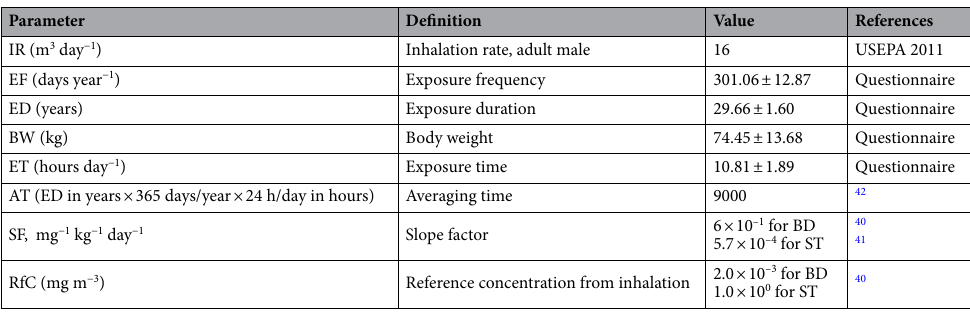
Table 2. Exposure and toxicological parameters used in carcinogenic and non-carcinogenic risk assessment in this